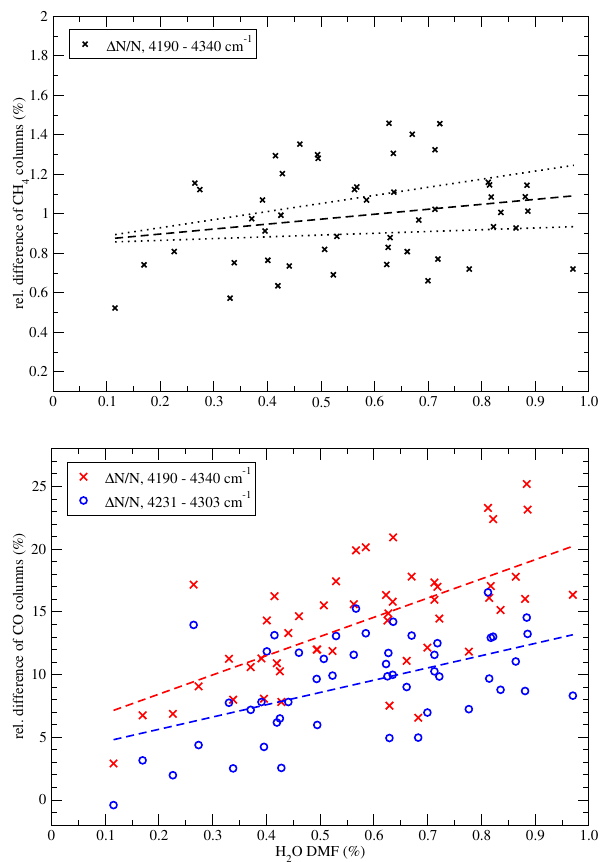
Fig. 8. Correlation of retrieval errors with humidity at Darwin. De- viations of CH 4 (upper panel) and CO columns (lower panel) with respect to the reference values are plotted against H 2 O DMF. Red crosses indicate nominal CO retrievals, blue circles show results for an optimised CO sub-window. Dashed lines denote linear fits.